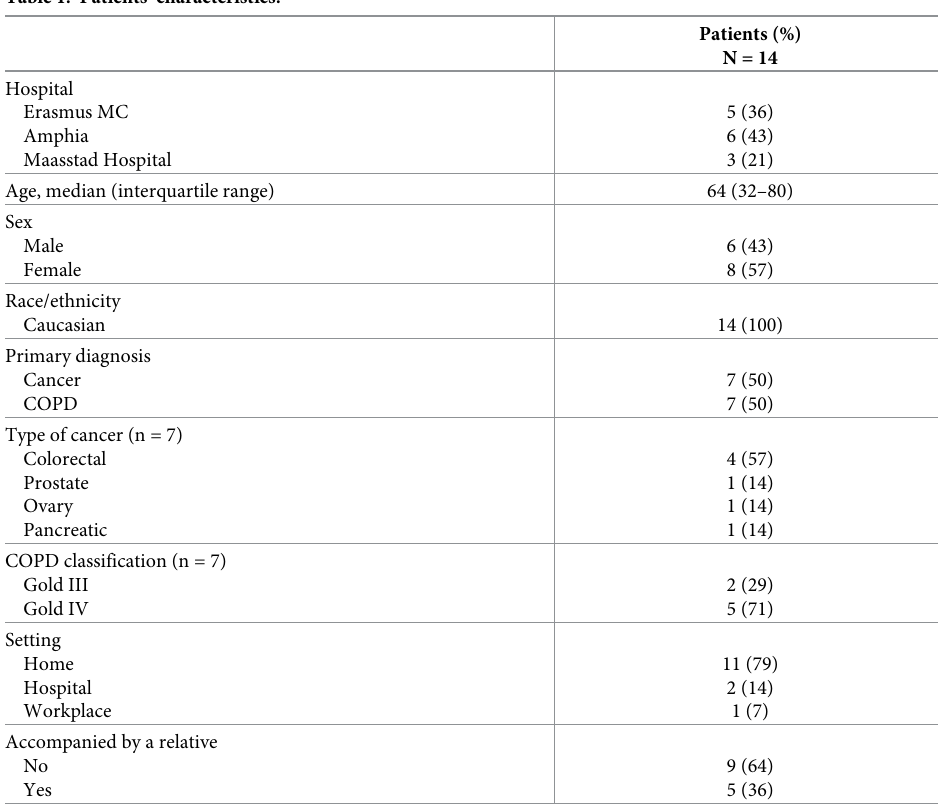
Table 1. Patients’